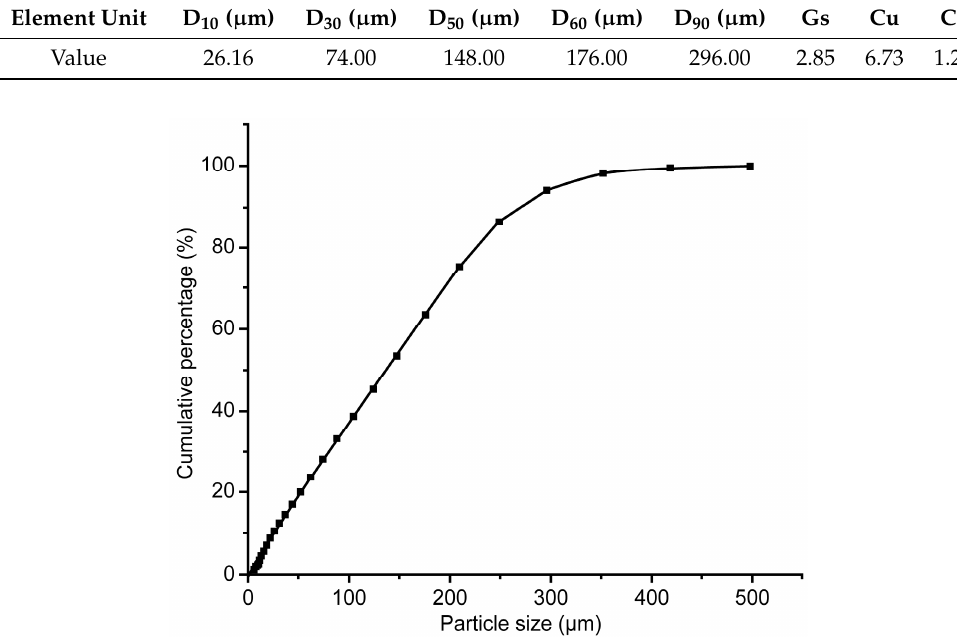
Figure 1. Particle size distributions obtained for the utilized ST.